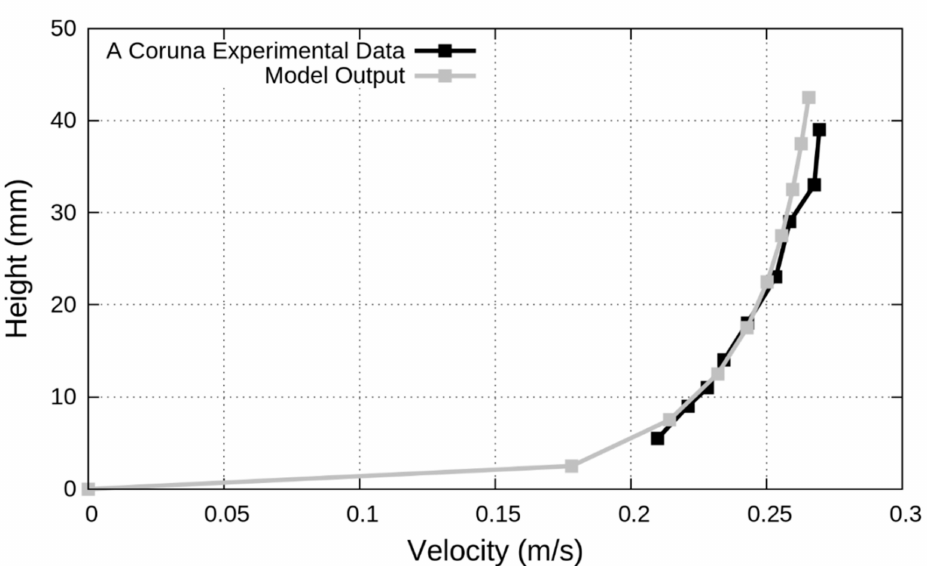
Figure 4. Velocity magnitude results at the lower flow area after 1 day of deposition from the A Coruña pilot plant experiments and 6 m from the inlet of the model prior to any deposition